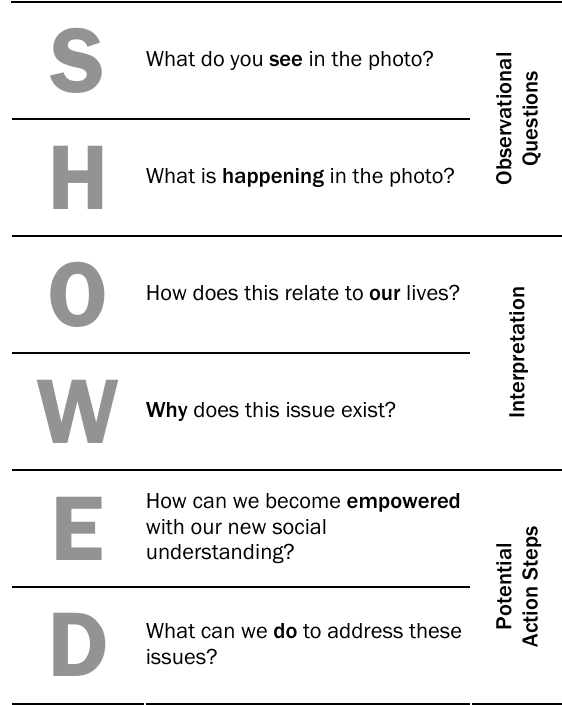
Figure 2. Overview of SHOWED Discussion